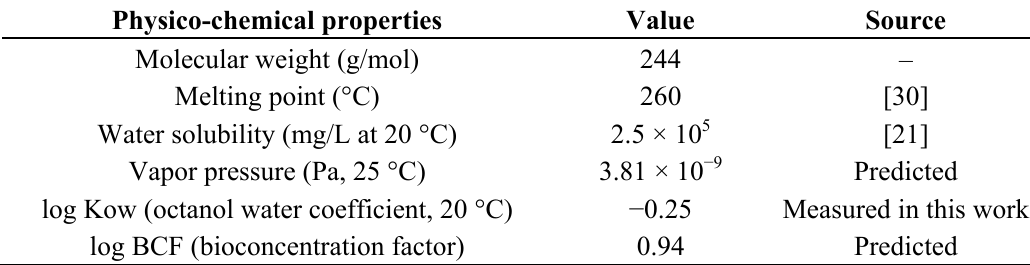
Table 3. Physico-chemical properties of zosteric acid measured and/or predicted by EPIsuite